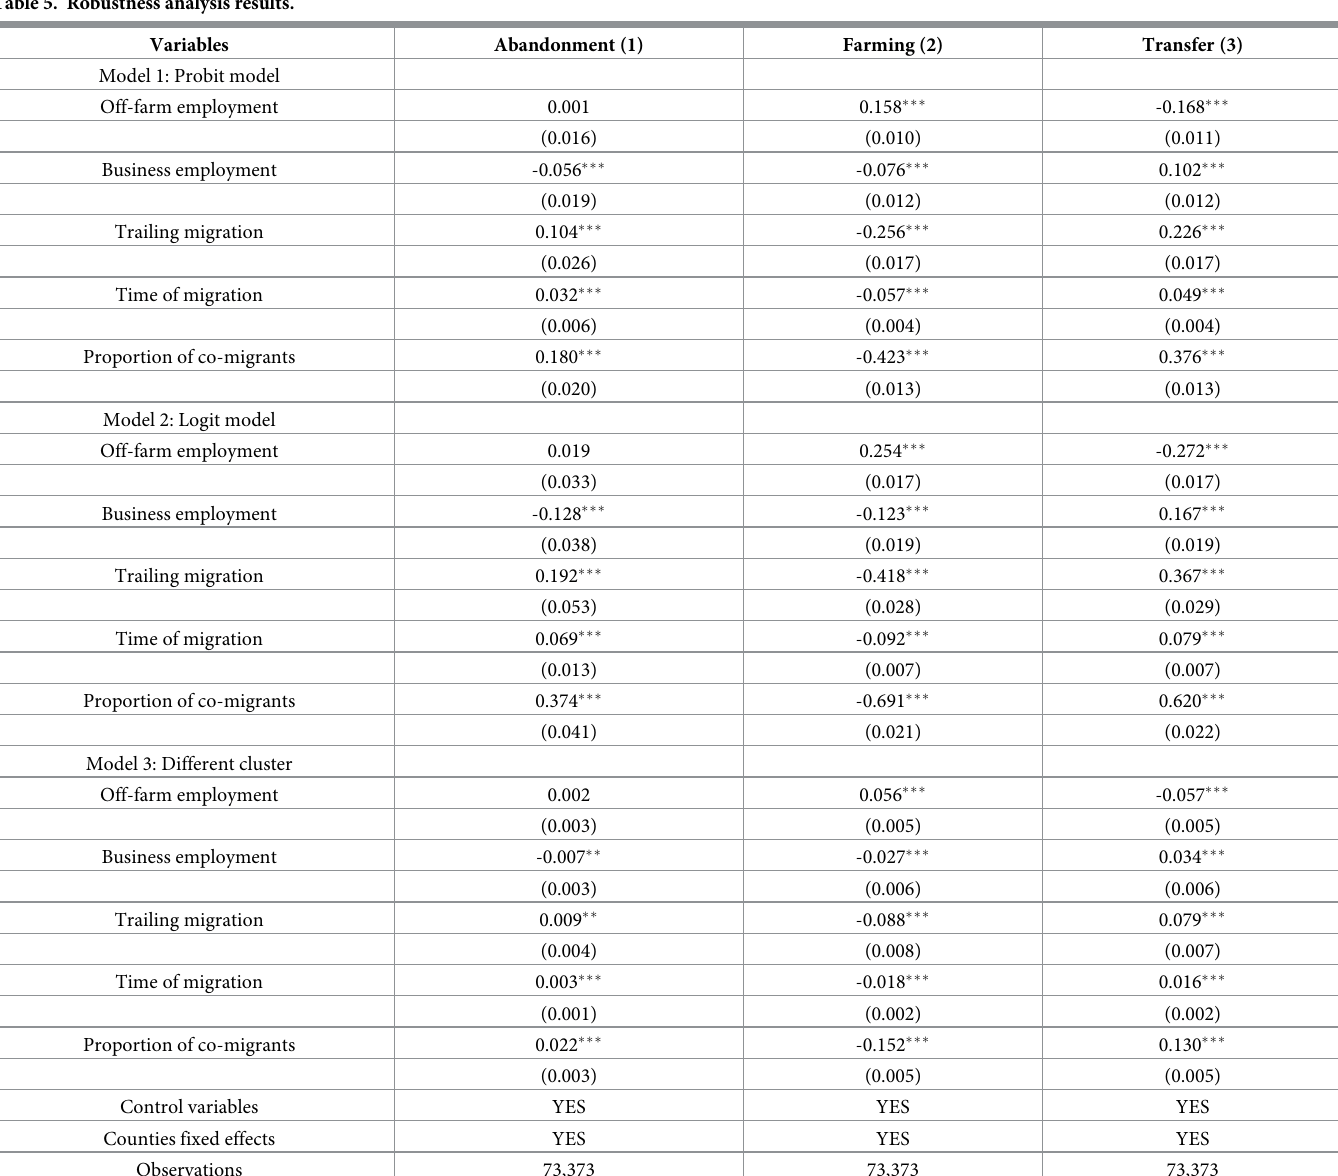
Table 5. Robustness analysis